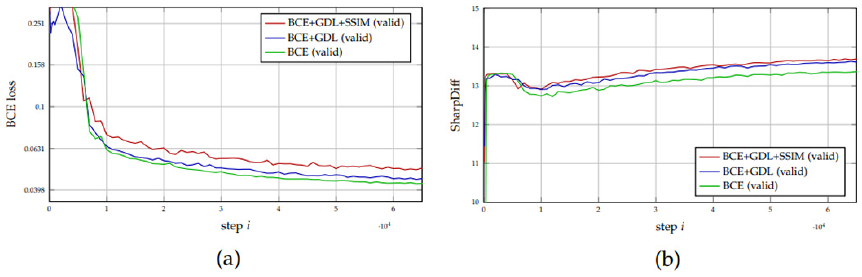
Fig. 12. Comparison of the validation loss using different objective